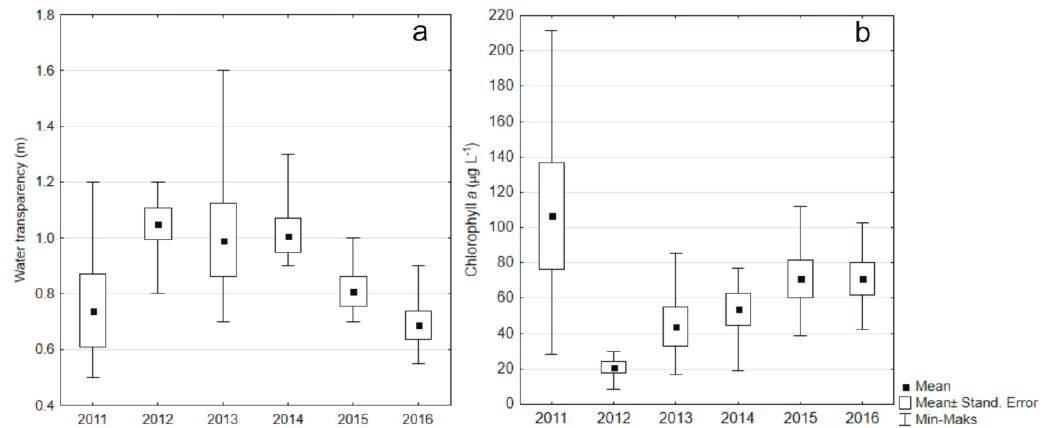
Figure 3. The mean values of water transparency ( a ) and chlorophyll a concentrations in depth